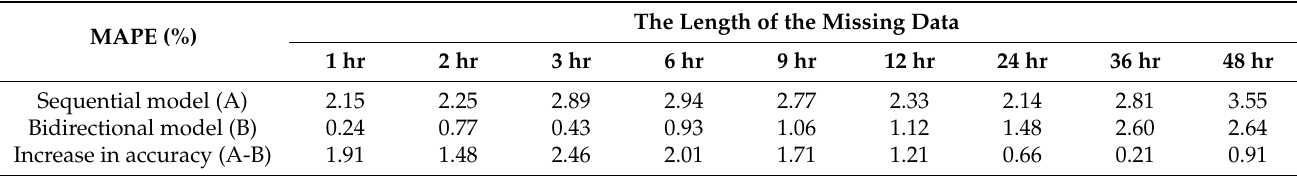
Table 5. An increase in the RNN model’s accuracy according to the order of learning data.